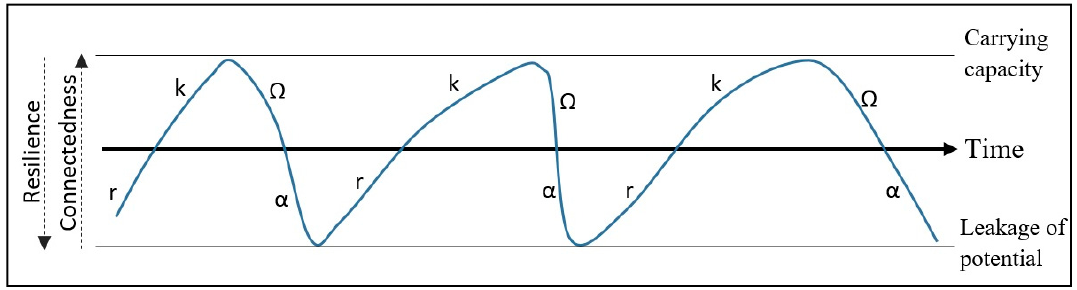
Figure 3. Explanatory diagram of the ‘adaptive curve’, including the four phases (r: exploitation, k: conservation, Ω : release, α : re-organisation), the variables (resilience and connectedness), and the conceptual upper and lower limits of the system (carrying capacity and loss of potential).